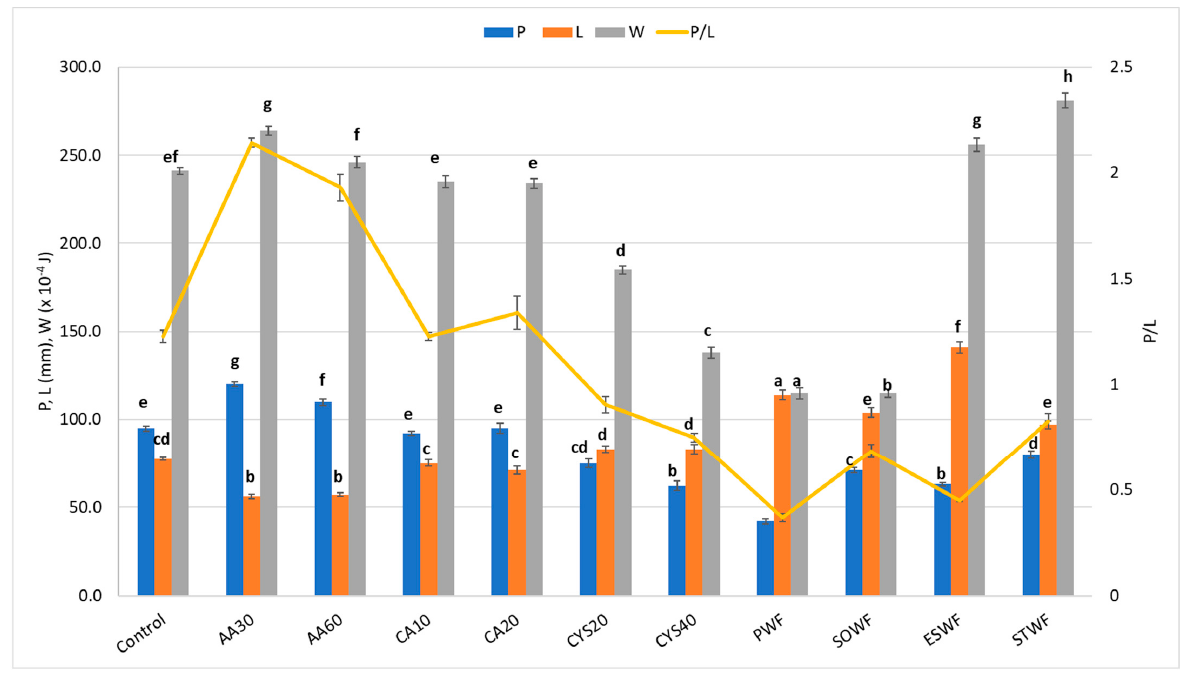
Figure 1. Variation of dough tenacity or maximum overpressure (P), average abscissa to rupture dough or biaxial extensibility (L), deformation energy (W), and the configuration ratio (P/L) of flours and control flour with added improvers (Ascorbic acid: AA30, AA60, Citric acid: CA10, CA20, L-Cysteine CYS20, CYS40). Similar letters over graph bars indicate no statistical difference for each particular characteristic of the various dough preparations (ANOVA with Tukey’s HSD multiple comparisons, p < 0.05).